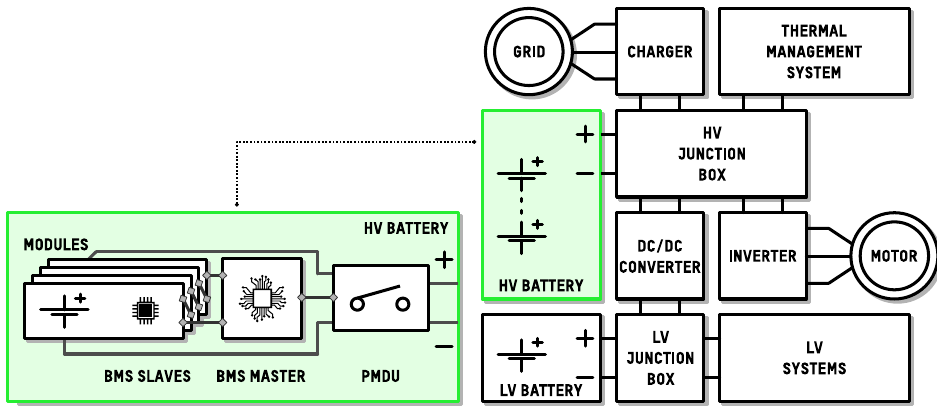
Figure 2. Application scenario